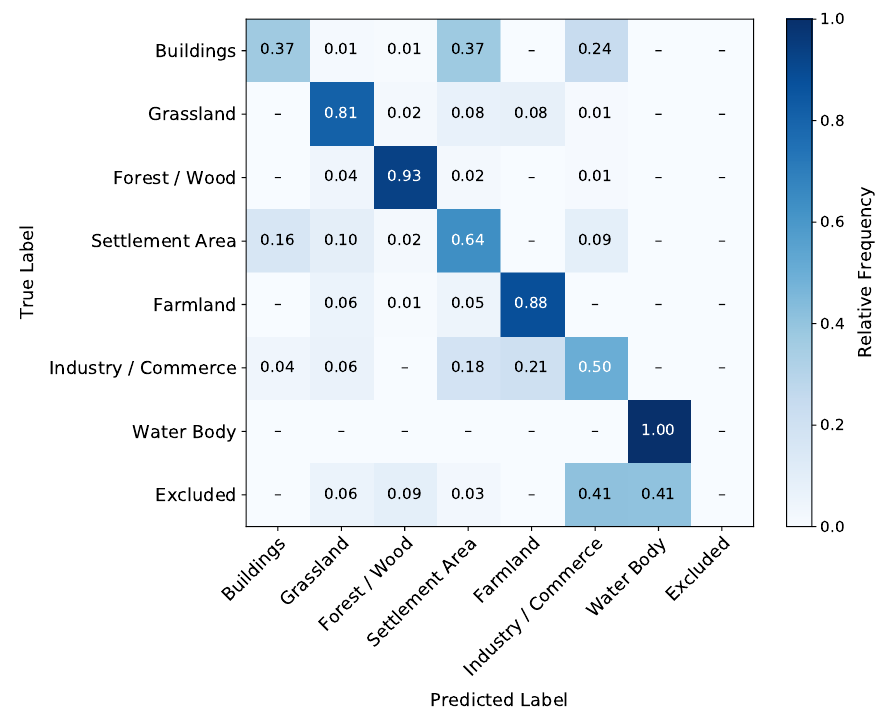
Figure 8. Normalized confusion matrix for the best-scoring ensemble of LSTM F models. The predic- tion is performed on the test subset of the 2016 data and compared to the GT.